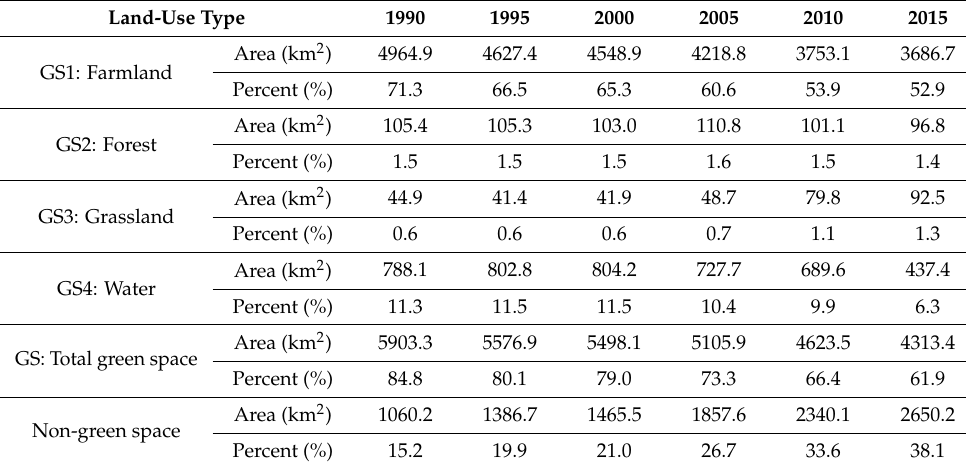
Table 3. The overall changes in urban green space (UGS) of Shanghai in 1990–2015.